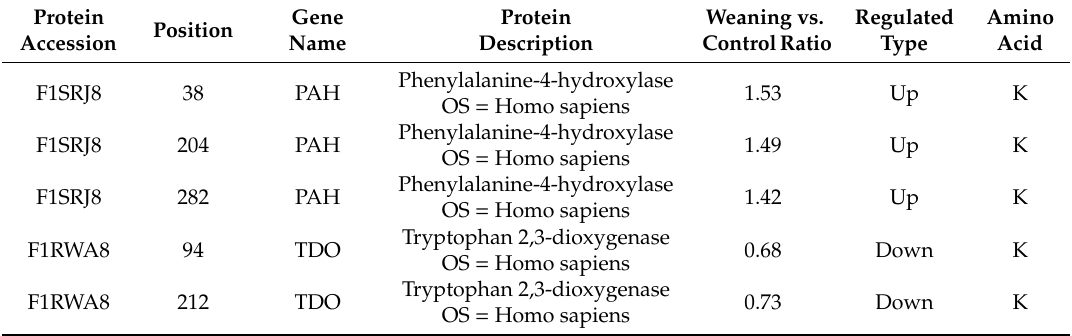
Figure 3. Lysine acetylation modify the key enzyme of hepatic aromatic amino acids (AAAs) metabolism altering the utilization of AAAs. The number of proteins and sites of up-regulated/down-regulated proteins. Table 2. Identification of acetylated phenylalanine hydroxylase (PAH) and tryptophan 2,3-dioxygenase (TDO) sites by mass